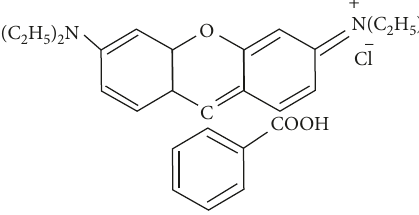
Scheme 1: The molecular structure of